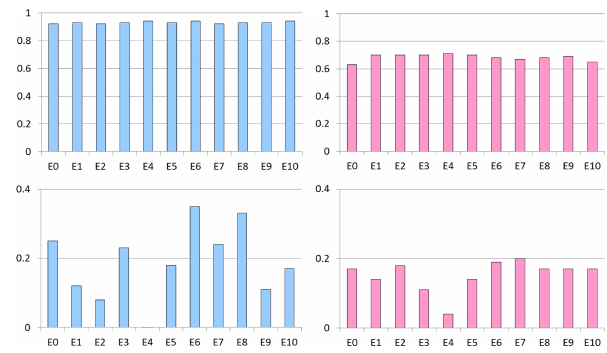
Figure 4. PC and HSS (top to bottom panels) for 4-category contin- gency tables for each experiment in western river basin (blue bars) and in eastern river basin (pink bars).